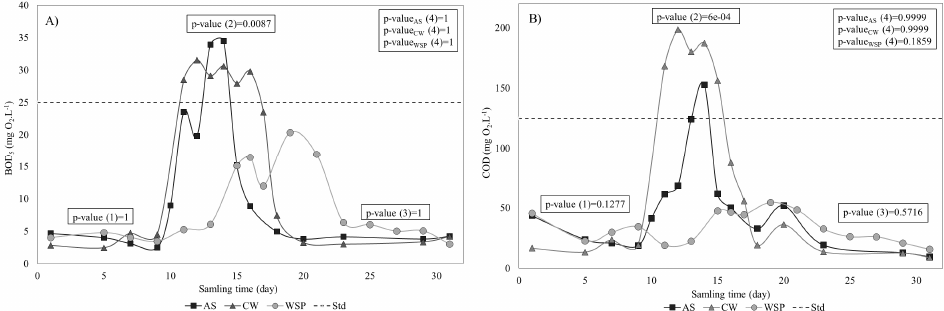
Figure 2. The OM effluent concentration of the Activated Sludge (AS), Constructed Wetland (CW) and Waste Stabilization Pond (WSP) with the p -value of four hypothetical tests during the peak load scenario (( A ): BOD 5 , ( B ): COD). The dot line represents the threshold of the effluent discharge according to the Flemish Environmental